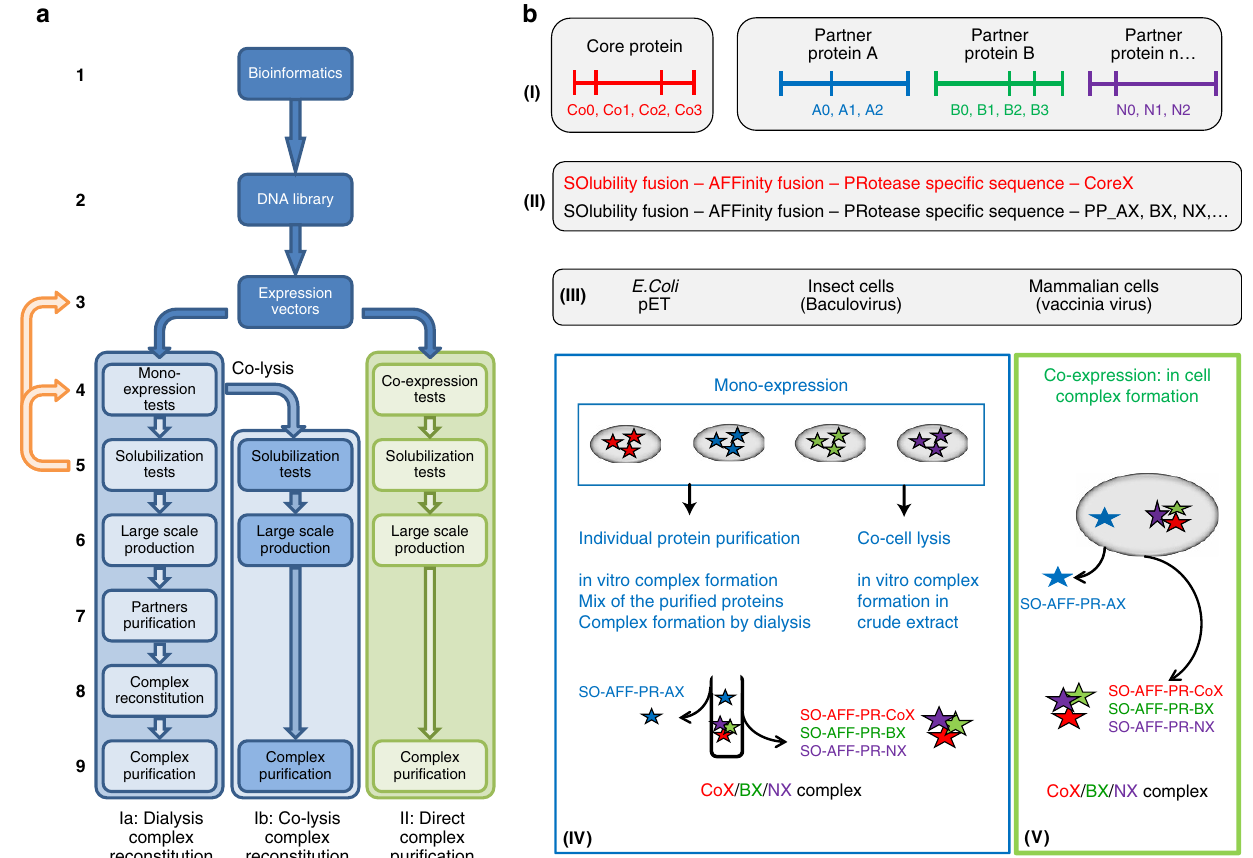
Figure 2 | General strategy used for production of stable complexes. ( a ) Flowchart describing the 9 steps used in the pipeline. After bioinformatics analysis ( a1 ) to define protein domains ( bI ), a DNA library is created. The proteins are then cloned in fusion with solubility and affinity tags ( bII ). Next they are transferred into expression vectors ( a3 ) for protein production in prokaryotic and eukaryotic cells ( bIII ). Two strategies are then tested. One is the production of each protein individually (a4 , bIV ) and complex reconstitution by dialysis ( a , line Ia ) or co-cell lysis ( a , line Ib ) and another is the co- expression of the different proteins together ( a , line II; bV ). After solubility tests, steps 3–5 are recycled until the optimal conditions for the proteins/ complex solubility and stability are found. After a large scale production ( a6 ) protein purification ( a7 , line Ia ) and complex reconstitution ( a8 , line Ia ) the complex is purified by affinity purification and size exclusion